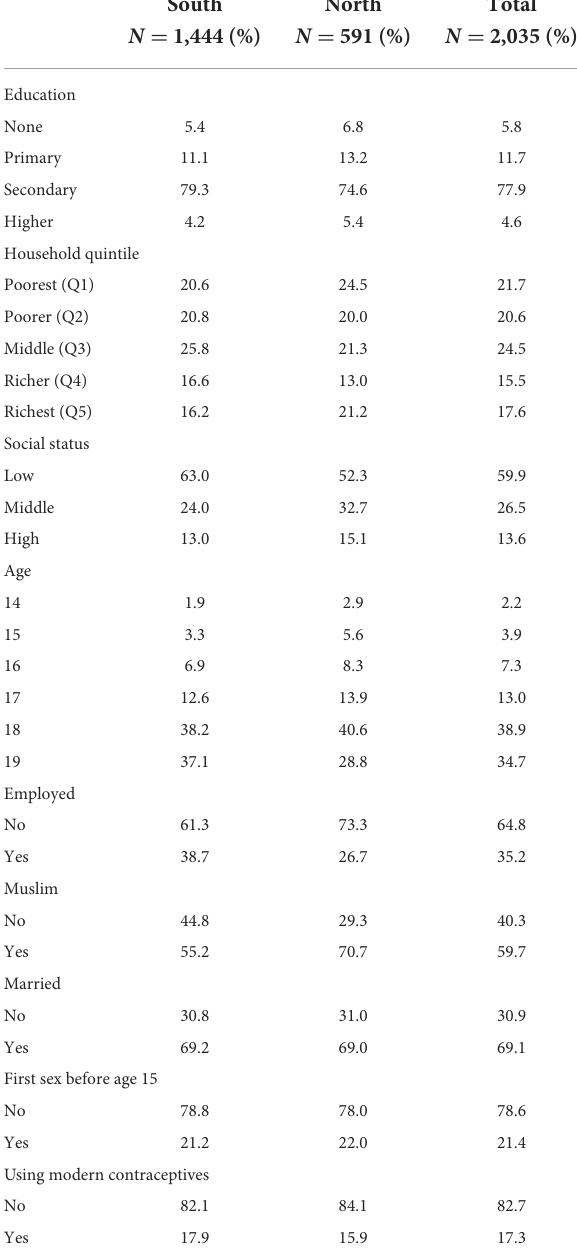
TABLE 1 Distribution of slum-dwelling adolescents by equity variables and the background characteristics of adolescent girls in selected urban slums in